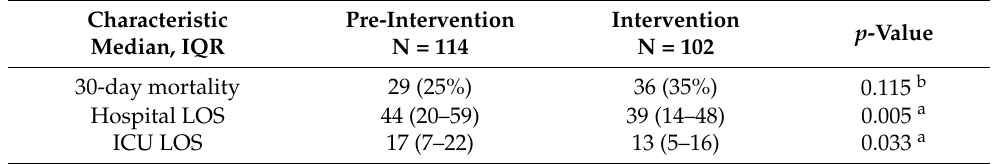
Table 2. Clinical outcomes of patients included in the study. Characteristic